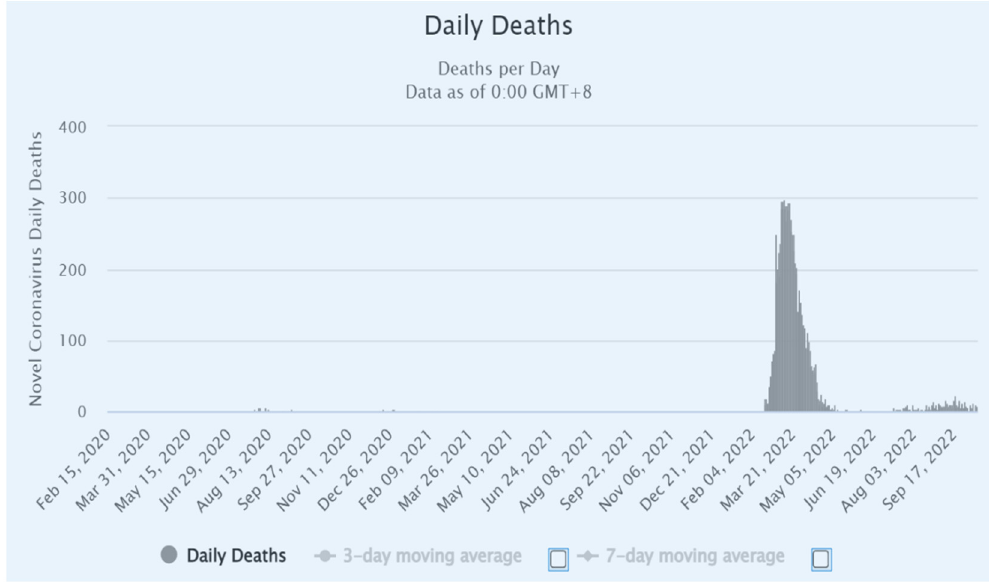
Figure 6. COVID-19 deaths in Hong Kong, China. Source: Worldometer (2022b) .